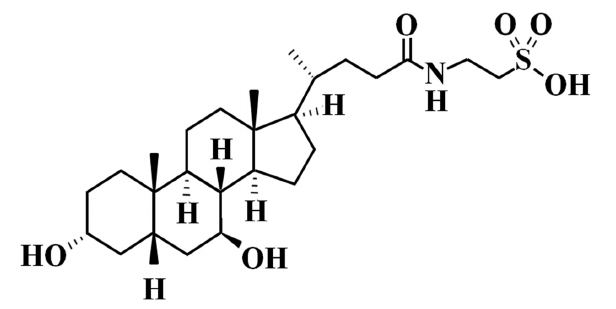
FIGURE 1 | Tauroursodeoxycholic Acid (TUDCA) chemical structure. Molecular Formula: C 24 H 45 NO 6